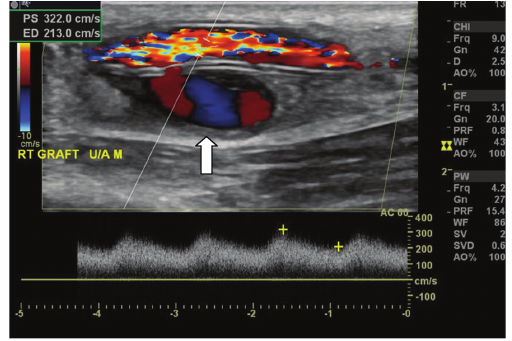
Figure 9: This ultrasound demonstrates a pseudoaneurysm (PSA), denoted by the white arrow, arising from the posterior wall of an access graft, presumably as a consequence of through-and-through puncture. Color Doppler shows the classic swirling “yin-yang” pattern of blood flow typically seen in PSAs.